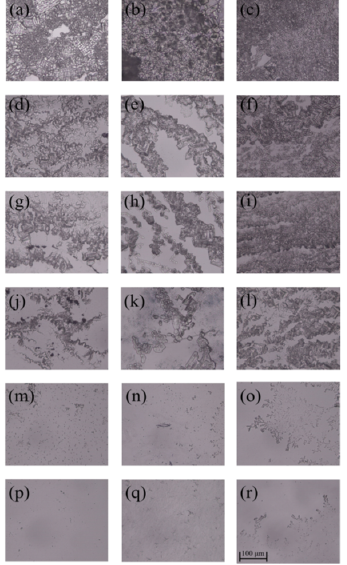
Figure 7. The inhibitory effect of AG-GT-1 on S. aureus biofilms: ( a – c ) are the S. aureus biofilms developed for 1, 3 and 5 days in control group, ( d – f ) are the S. aureus biofilms treated with AG-GT-1 at a concentration of 1/4 MIC for 1, 3 and 5 days, ( g – i ) are the S. aureus biofilms treated with AG-GT-1 at a concentration of 1/2 MIC for 1, 3 and 5 days, ( j – l ) are the S. aureus biofilms treated with AG-GT-1 at a concentration of MIC for 1, 3 and 5 days, ( m – o ) show the S. aureus biofilms treated with AG-GT-1 at a concentration of 2 MIC for 1, 3 and 5 days, ( p – r ) present the S. aureus biofilms treated with AG-GT-1 at a concentration of 4 MIC for 1, 3 and 5 days, respectively.